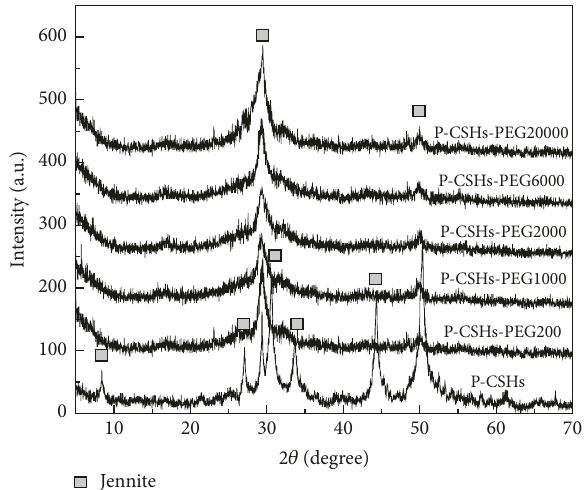
Figure 2: The XRD patterns of porous calcium silicate hydrates modified by PEG with different molecular